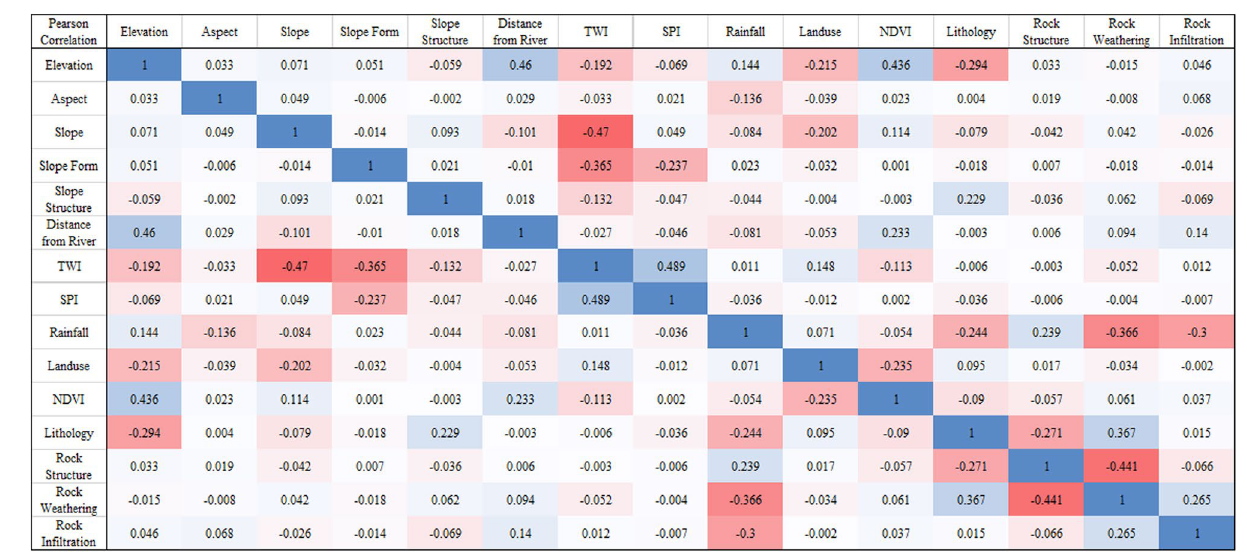
Figure 6. PCC matrix of 11 basic factors and 4 rock–soil characteristic